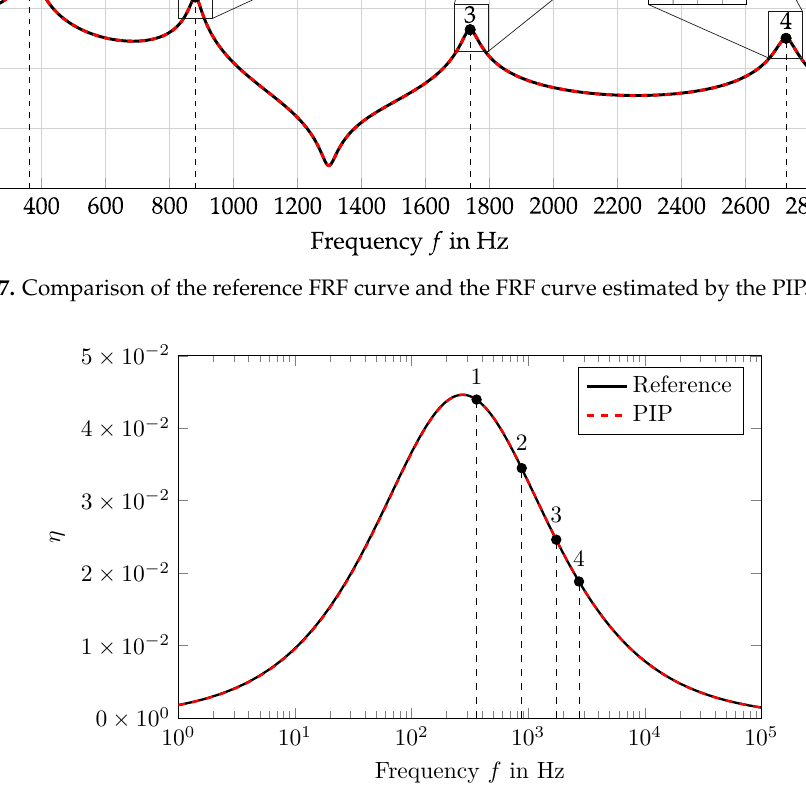
Figure 8. Schematically representation of a peak including the reference